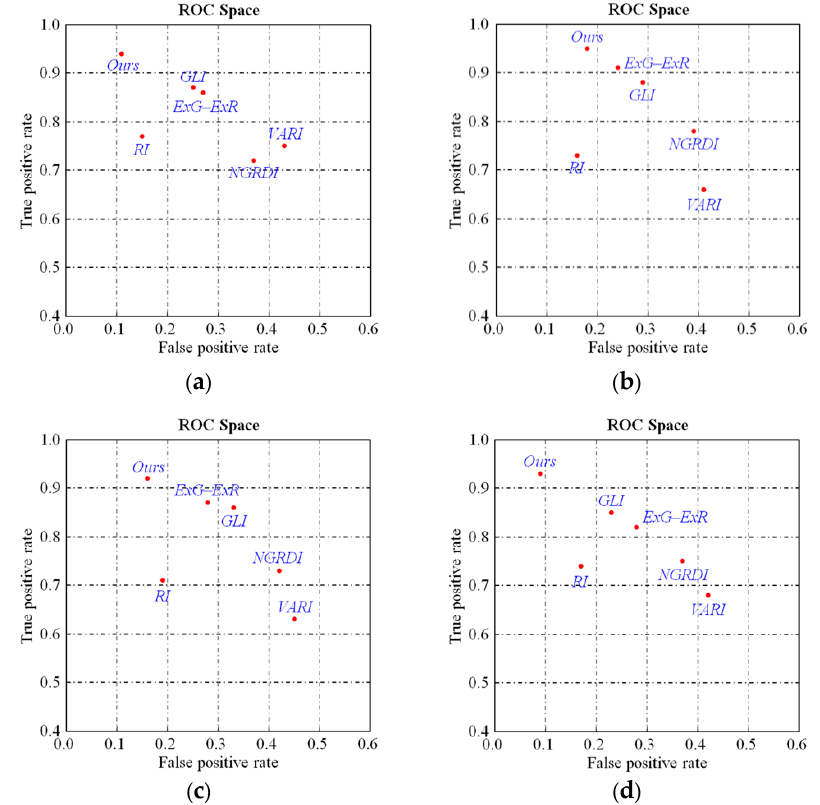
Figure 6. Examples to illustrate the accuracy of vegetation detection by using different datasets. ( a ) and ( b ) are the results of vegetation detection in two urban areas; ( c ) and ( d ) are the results of vegetation detection in two rural